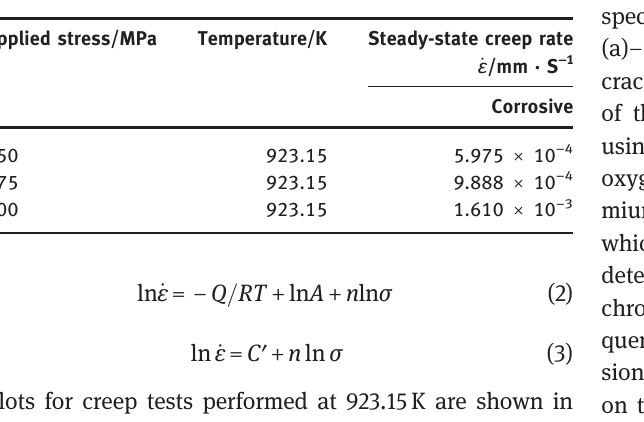
Figure 3: (a) Compression creep curves and (b) the relationship of steady- state creep rates with applied stresses of spe- cimens in hot corrosive